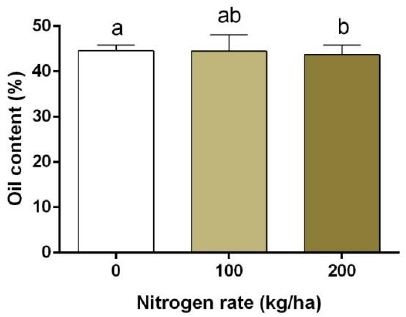
Figure 5. Effects of N application on seed oil content of rapeseed. Different letters on the top of the bars indicate significant difference at p < 0.05 by Duncan. bars indicate significant difference at p < 0.05 by